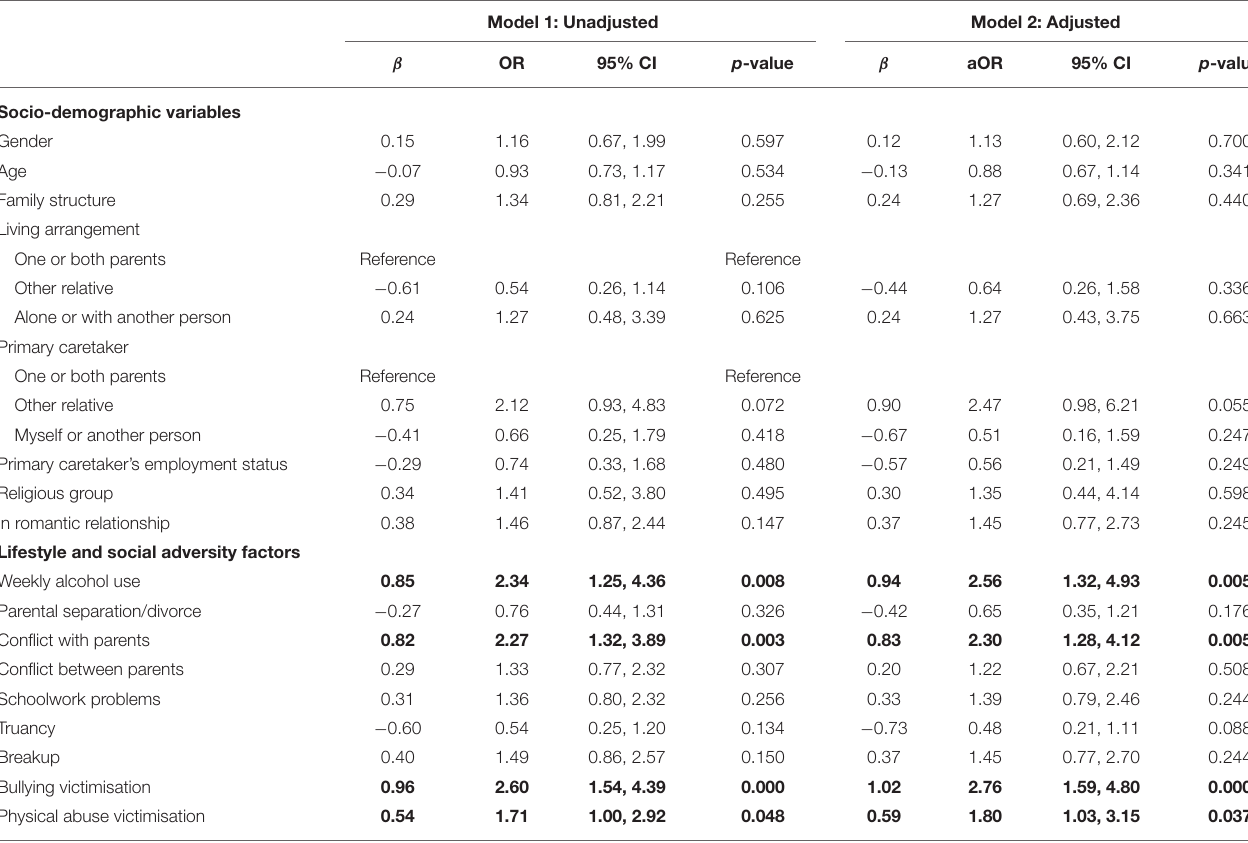
TABLE 5 | Multivariate associations: self-harm behaviour. Model 1: Unadjusted Model 2: Adjusted β OR 95% CI 95% CI p